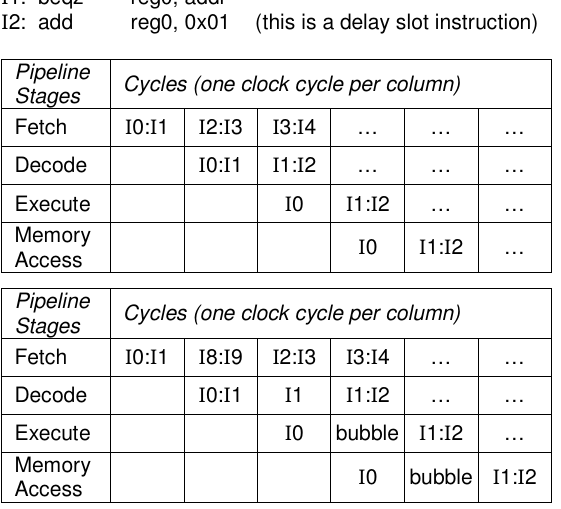
Figure 14. Example of a branch instruction located in the second slot and the corresponding delay slot instruction I2 (top) present and (bottom) not present in the fetch unit.